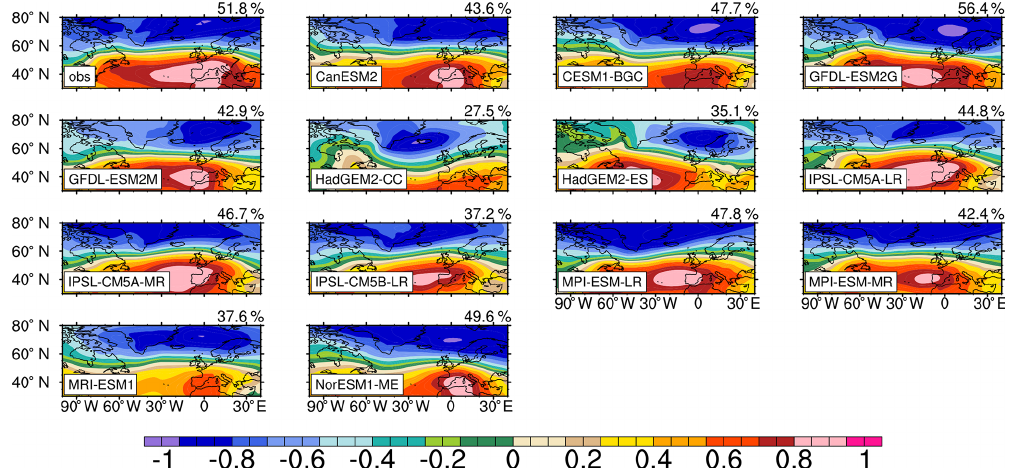
Figure 1. EOF1 of observed and simulated standardized winter-average sea level pressure over a particular region of the North Atlantic (30–80 ◦ N, 100 ◦ W–40 ◦ E). The time periods for the observation and models range from 1965 to 2015 and from 1955 to 2005, respectively. The simulated results are based on a historical experiment of CMIP5 (r1i1p1).